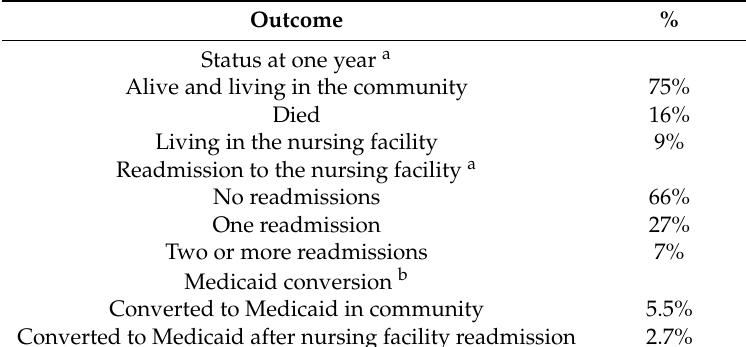
Table 4. Outcomes at 365 Days after transition from the nursing facility (N = 925 a , 820 b